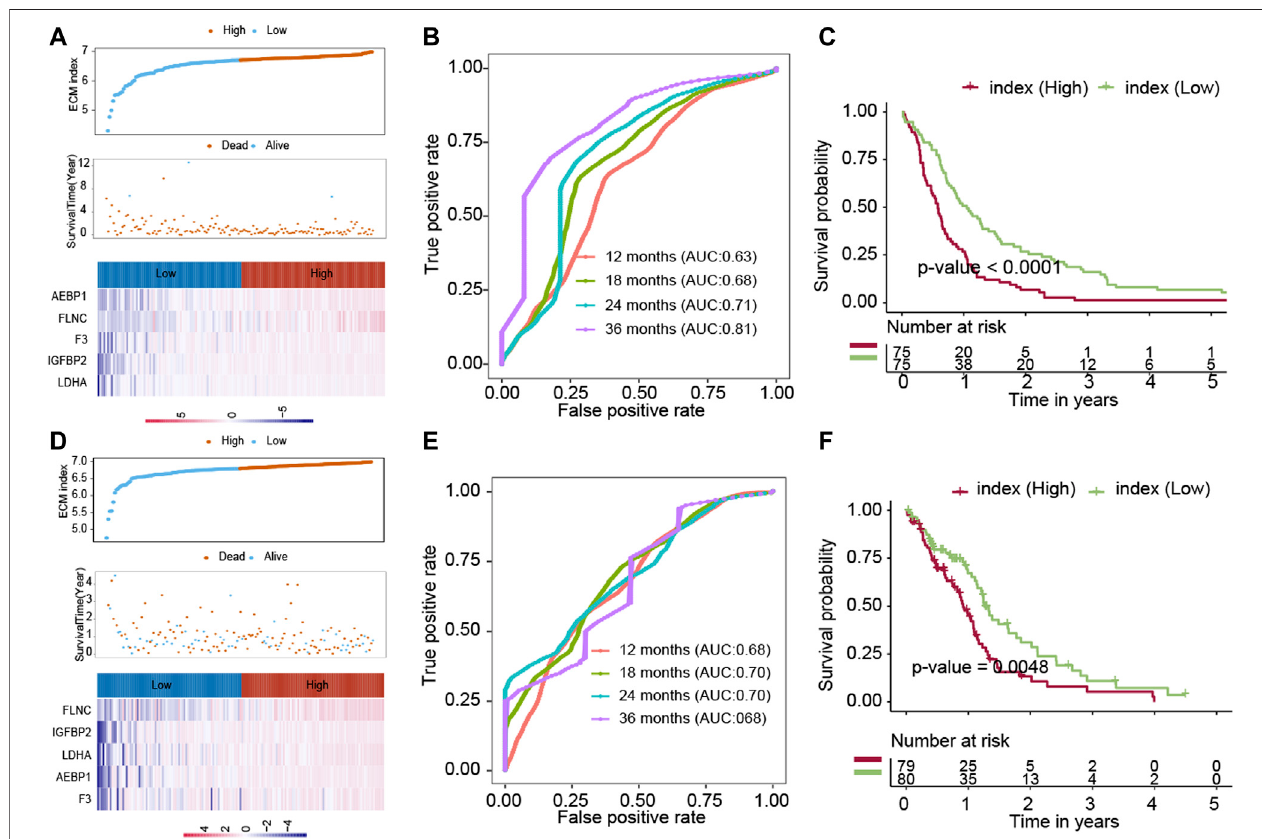
FIGURE3| EvaluationoftheECMindexintheinternalvalidation datasets (GSE16011 andTCGA-GBM).TheECMindexesofallpatients intheGSE16011 dataset (A – C) and the TCGA-GBM (D – F) dataset were calculated by the same formula and were divided into a high- and a low-index group.